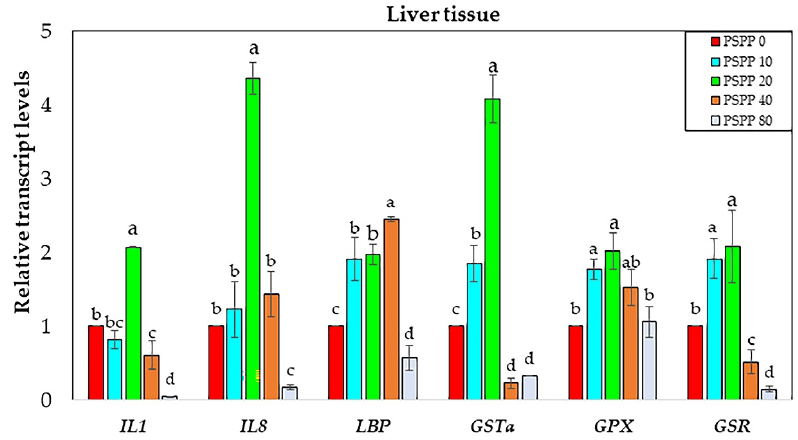
Figure 4. Expression transcript levels of interleukin-1 ( il-1 ), interleukin-8 ( il-8 ), lipopolysaccharide- binding protein ( lbp ), glutathione S-transferase- α ( gst- α ), glutathione peroxidase ( gpx ), and glutathione reductase ( gsr ) in liver tissues of Nile tilapia ( n = 5) fed diets supplemented 0 g kg − 1 PSPP, 10 g kg − 1 PSPP, 20 g kg − 1 PSPP, 40 g kg − 1 PSPP, and 80 g kg − 1 PSPP after eight weeks of feeding. The mRNA transcript levels of immune and antioxidant genes were normalized by 18S rRNA . The mRNA transcript level of the 0 g kg − 1 PSPP control group was set at 1. Data are presented as mean ± SE. Significantly different levels are denoted by superscript letters ( p < 0.05).